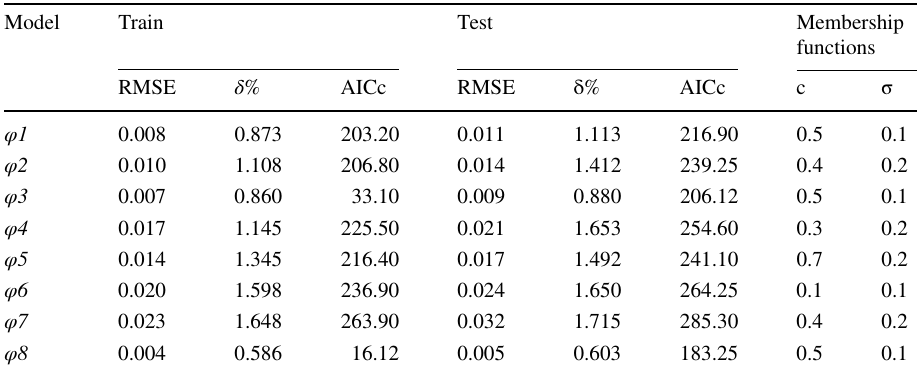
Table 10 Evaluation of hybrid approach in WP and yield estimation